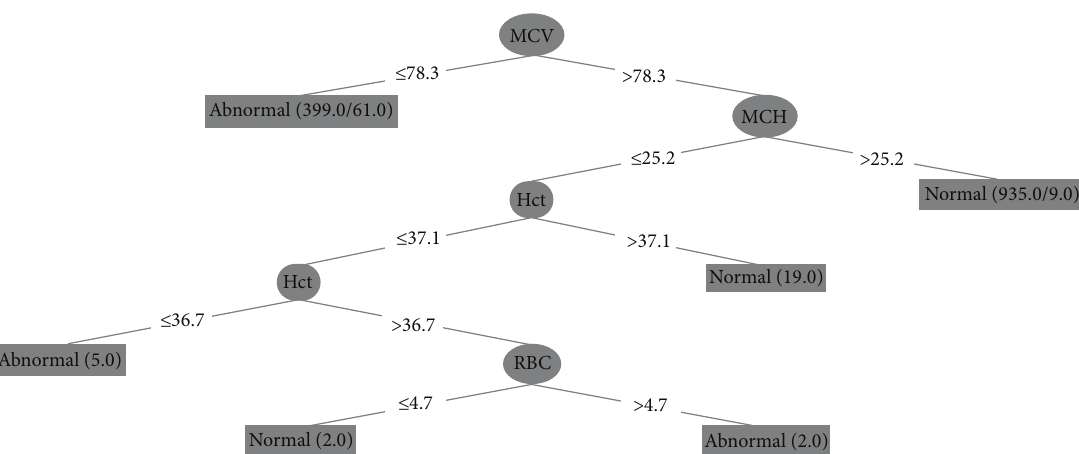
Figure 1: The decision tree from J48 algorithm in predicting RBC morphology. If MCV is less than or equal to 78.3 fL, RBC is labeled as abnormal RBC morphology but if MCV is more than 78.3 fL and MCH is more than 25.2 pg, RBC is still labeled as normal. And if MCH is less than or equal to 25.2 pg but Hct is greater than 37.1%, RBC is normal. On the other hand, if Hct is less than or equal to 36.7%, RBC is abnormal. But if Hct is between 36.7 and 37.1% and RBC is less than or equal to 4.7×10 12 cell/L, it will most likely be normal RBC morphology. However, if RBC is more than 4.7 × 10 12 cell/L, it is abnormal RBC morphology.